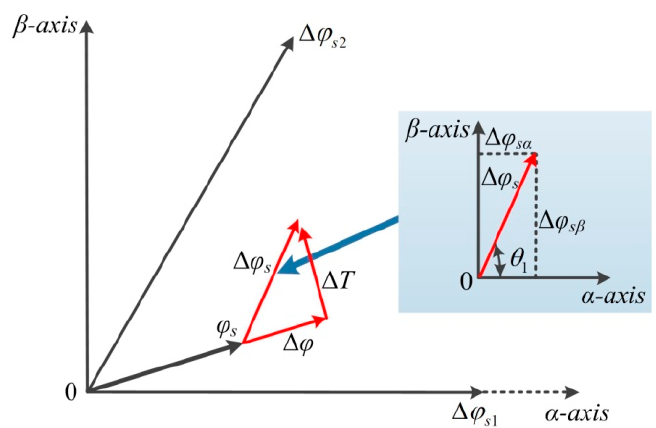
Figure 6. Analysis of error compensational effects in steady-state.